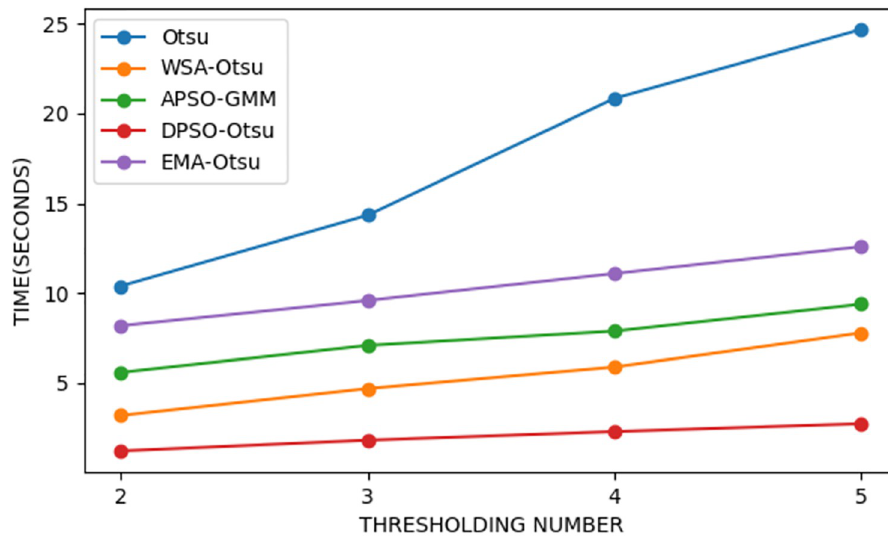
Fig 6. The thresholding time of the proposed method vs. other